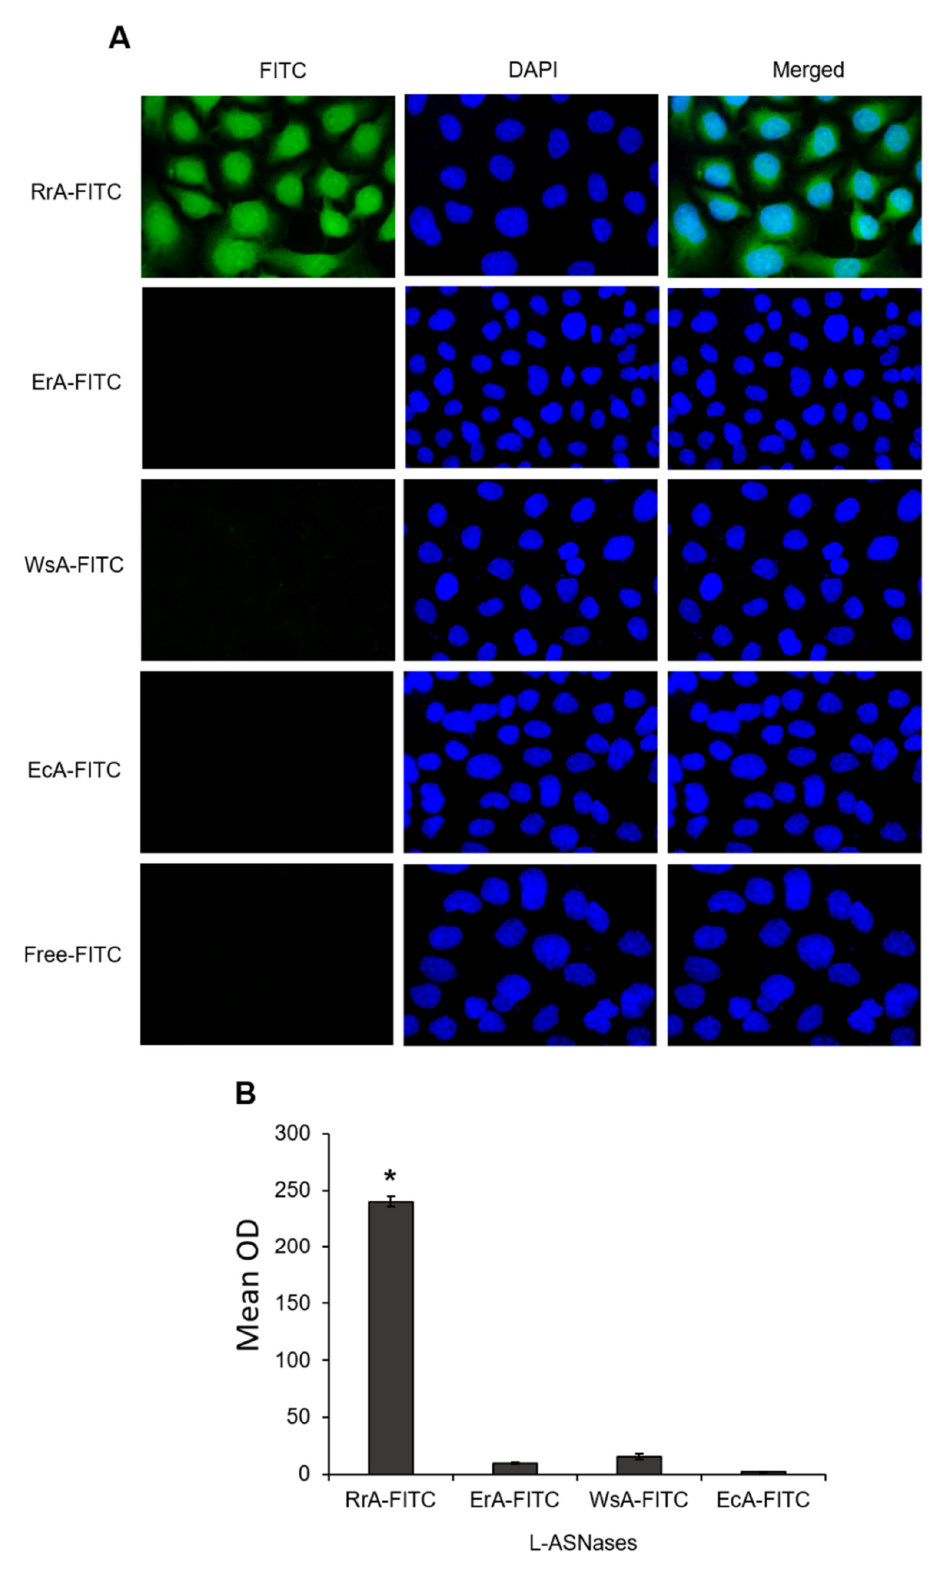
Figure 3. Induction of FITC-positive cells after treatment with FITC-conjugated L-ASNases. ( A ) Representative fluorescent microscopy images of SKBR3 cell incubated with different FITC-conjugated L-ASNases for 12 h and stained with DAPI (green, FITC, and blue, DAPI, magnification × 40). ( B ) Quantification of the FITC mean optical density (OD) in cells. * p ≤ 0.05 vs. cells incubated with free FITC.